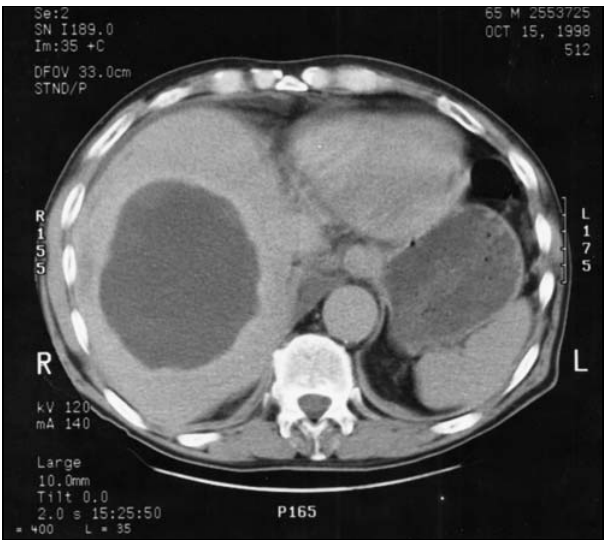
Figure 2) Computed tomography scan of the abdomen showing mas- sive liver abscess in the right lobe of the